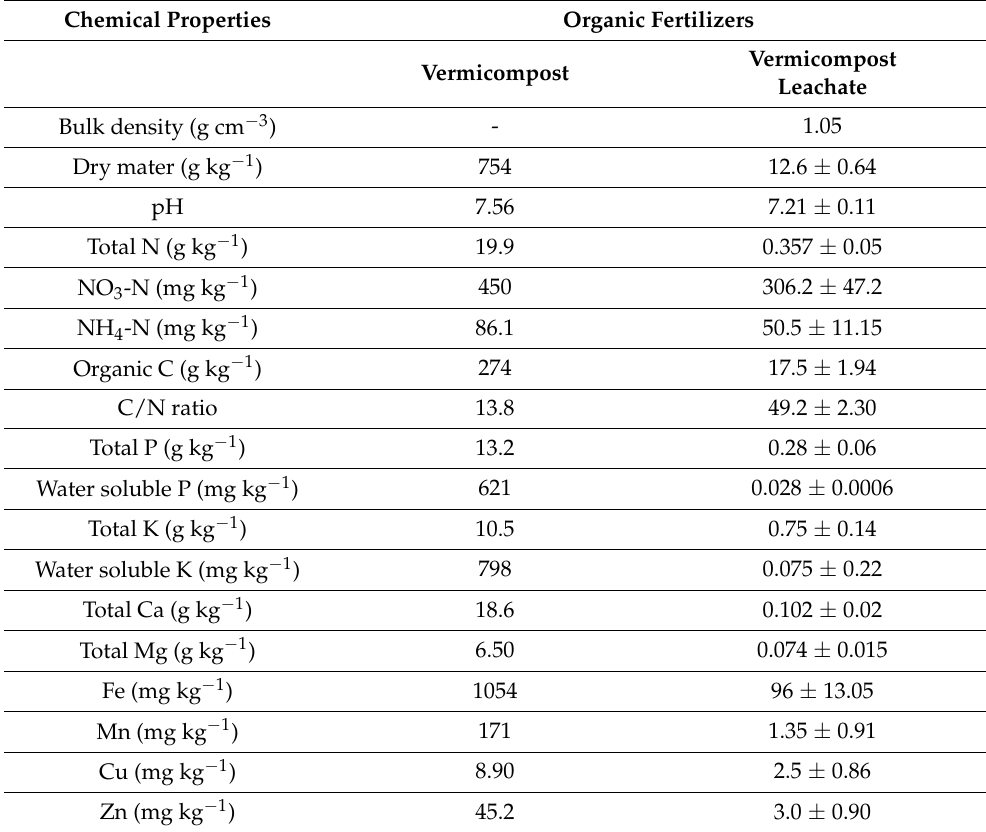
Table 2. Chemical properties of organic